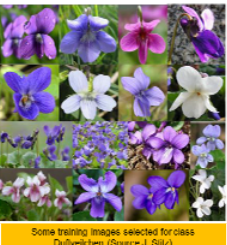
Figure 6: Some training images of Sweet Violet (Source: Stitz, 2014).